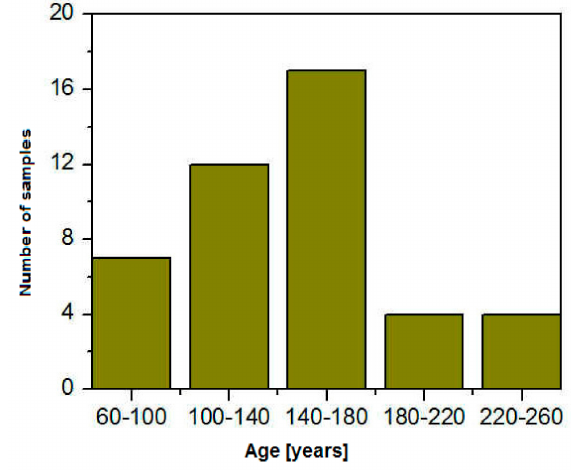
Figure 2. The tree samples distribution by